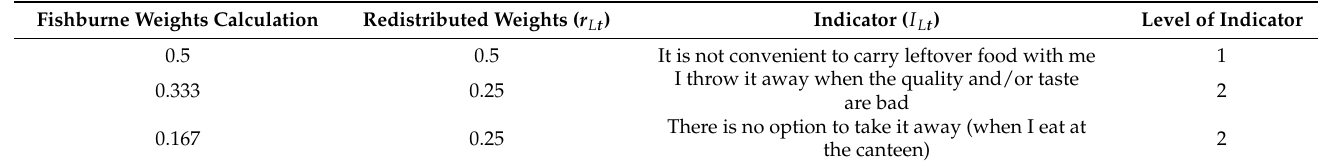
Table 6. Reasoning indicators for throwing away food leftovers.